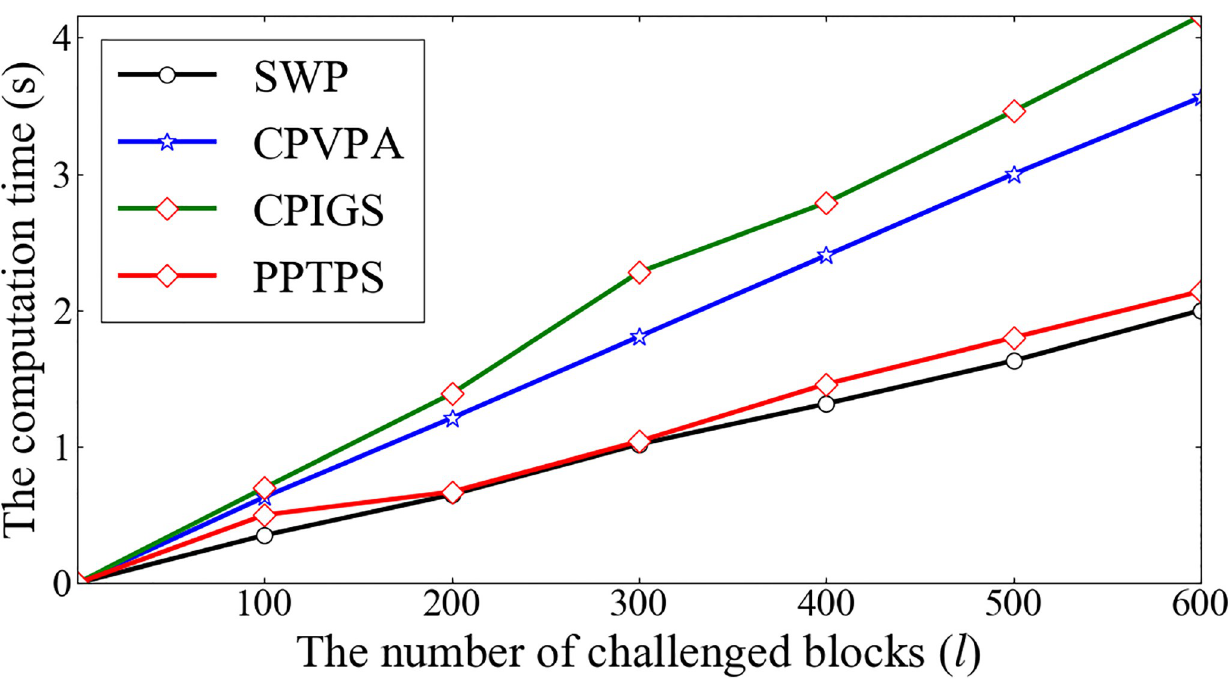
Fig 4. The computation cost of the auditor side.